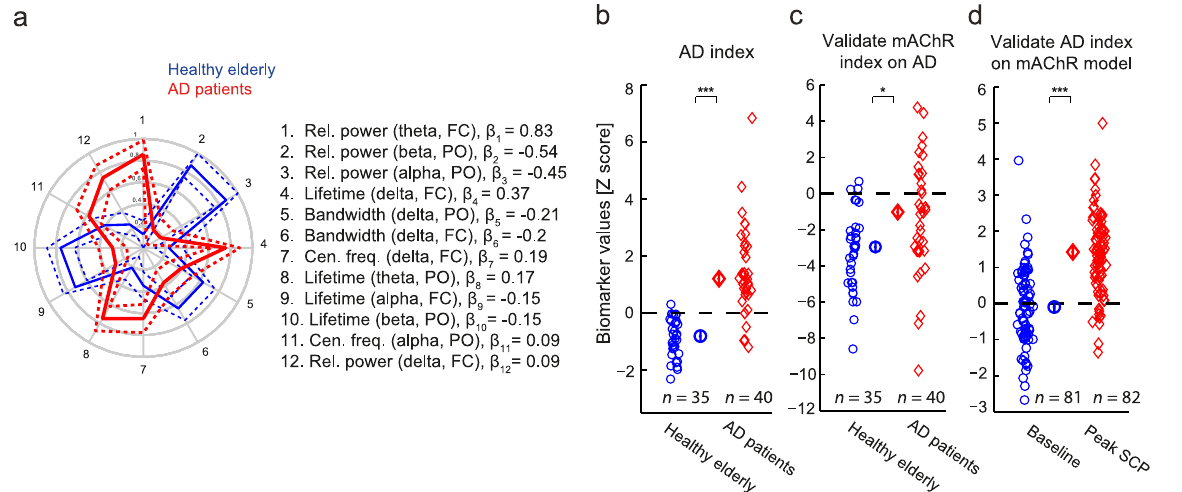
Figure 5. The Alzheimer’s index captures scopolamine-induced effects and validates scopolamine as a model of AD pathophysiology. ( a ) Illustration of the twelve biomarkers composing the AD index. Several of these biomarkers also compose the scopolamine index, with the same directionality of change in both the scopolamine-induced cognitive impairment and Alzheimer’s disease. The values plotted are as explained in Fig. 3B. ( b ) AD index separates healthy elderly from Alzheimer’s disease patients with high precision. ( c ) The mAChR index discriminates the healthy elderly and AD patients albeit less accurately than the AD index. ( d ) Validating the AD index on the scopolamine data gives much better